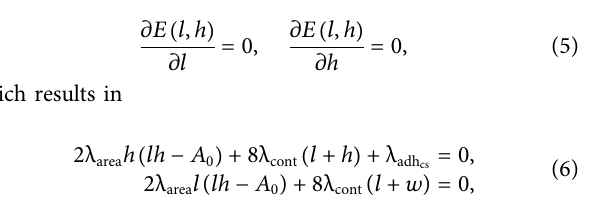
Frontiers in Cell and Developmental Biology |